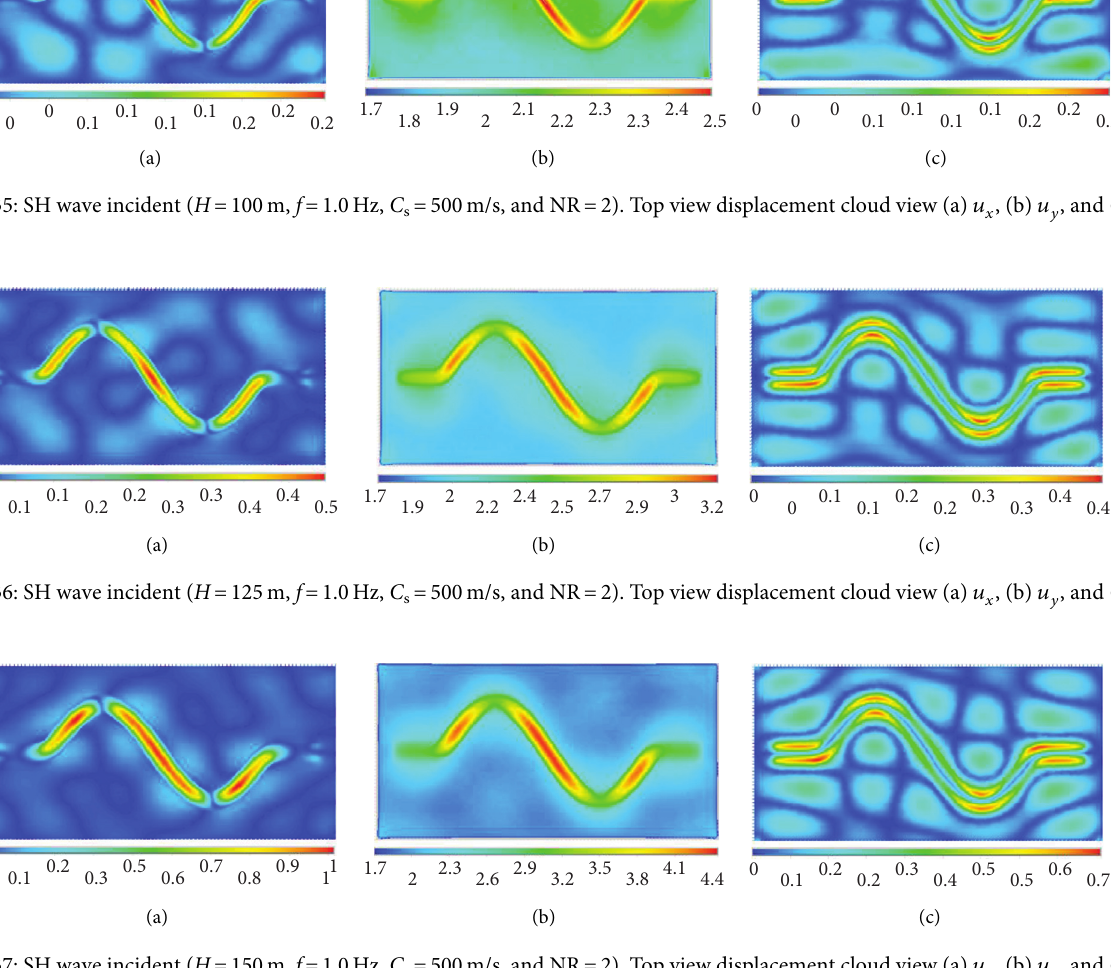
� 500m/s, and NR � 2). Top view displacement cloud view (a) u s